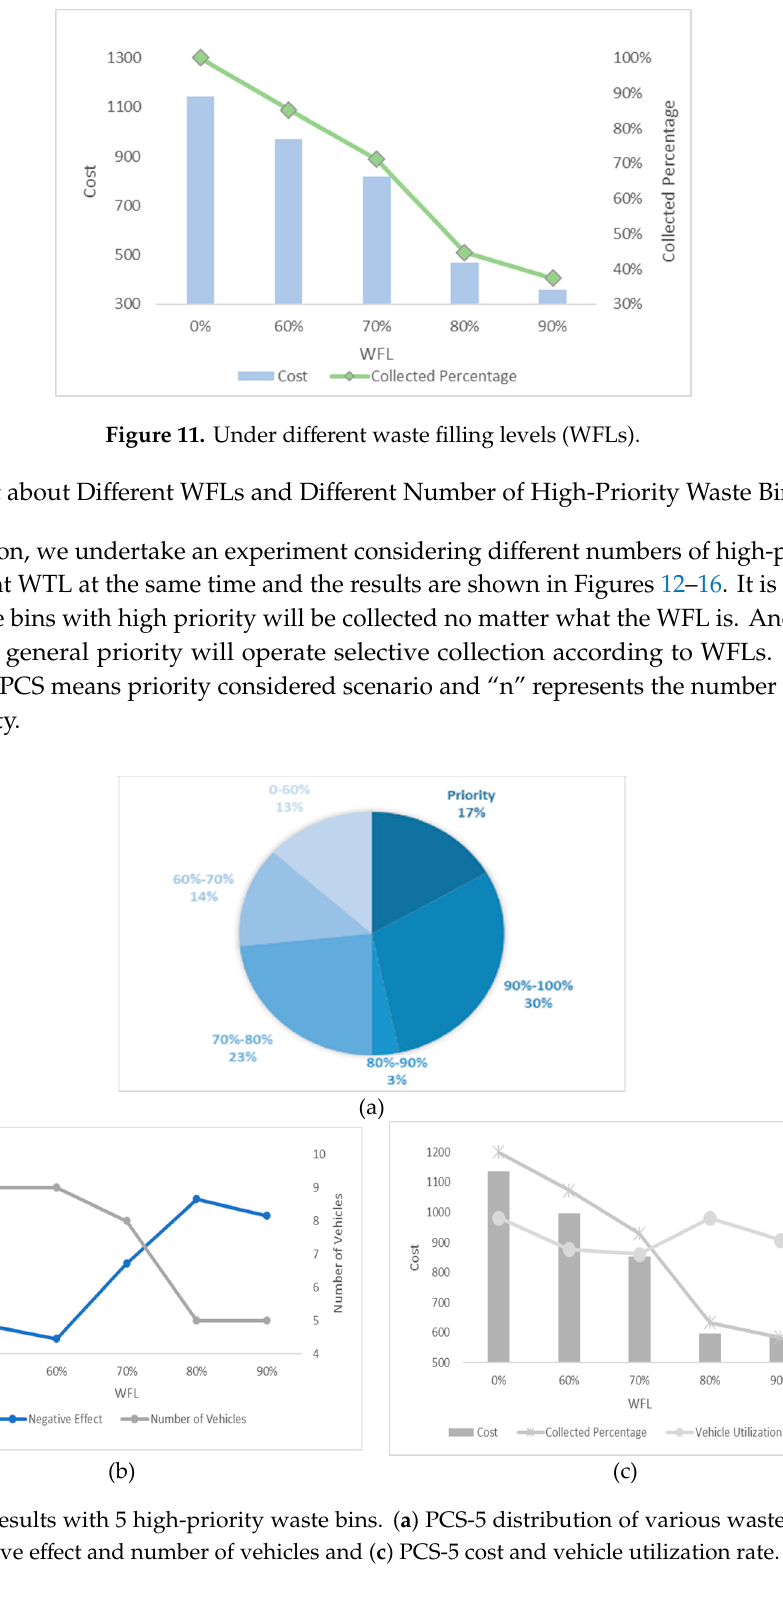
(c) Figure 13. Results with 10 high-priority waste bins. ( a ) PCS-10 distribution of various waste bins, ( b ) PCS-10 negative effect and number of vehicles and ( c ) PCS-10 cost and vehicle utilization rate.